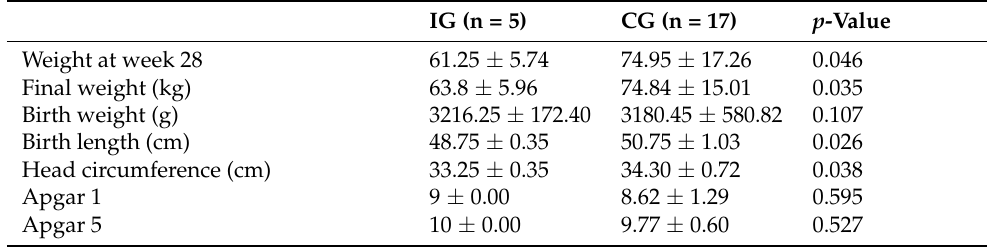
Table 7. Women diagnosed with